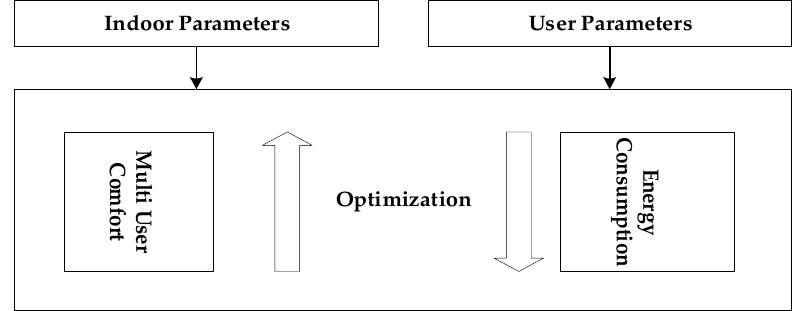
Figure 8. The objective of future study in smart homes.